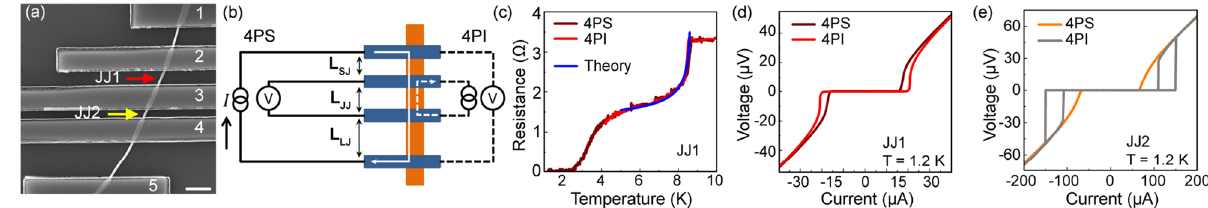
Figure 1. ( a ) SEM image of the Nb/Au-NW/Nb hybrid structure. The red arrow marks JJ1 weak link ( L = 645 nm), the yellow one marks JJ2 weak link ( L = 360 nm). Numbers 1–5 are the serial numbers of the Nb electrodes. The scale bar is 1 µ m. ( b ) A sketch of the two measurement schemes for which the following graphs are given: standard 4-probe scheme (4PS) and inverted 4-probe scheme (4PI). ( c ) Experimental (red and brown lines) and theoretical (blue line) R ( T ) dependencies for the JJ1. ( d , e ) are I ( V ) characteristics, for the JJ1 and JJ2, respectively, measured using different schemes.